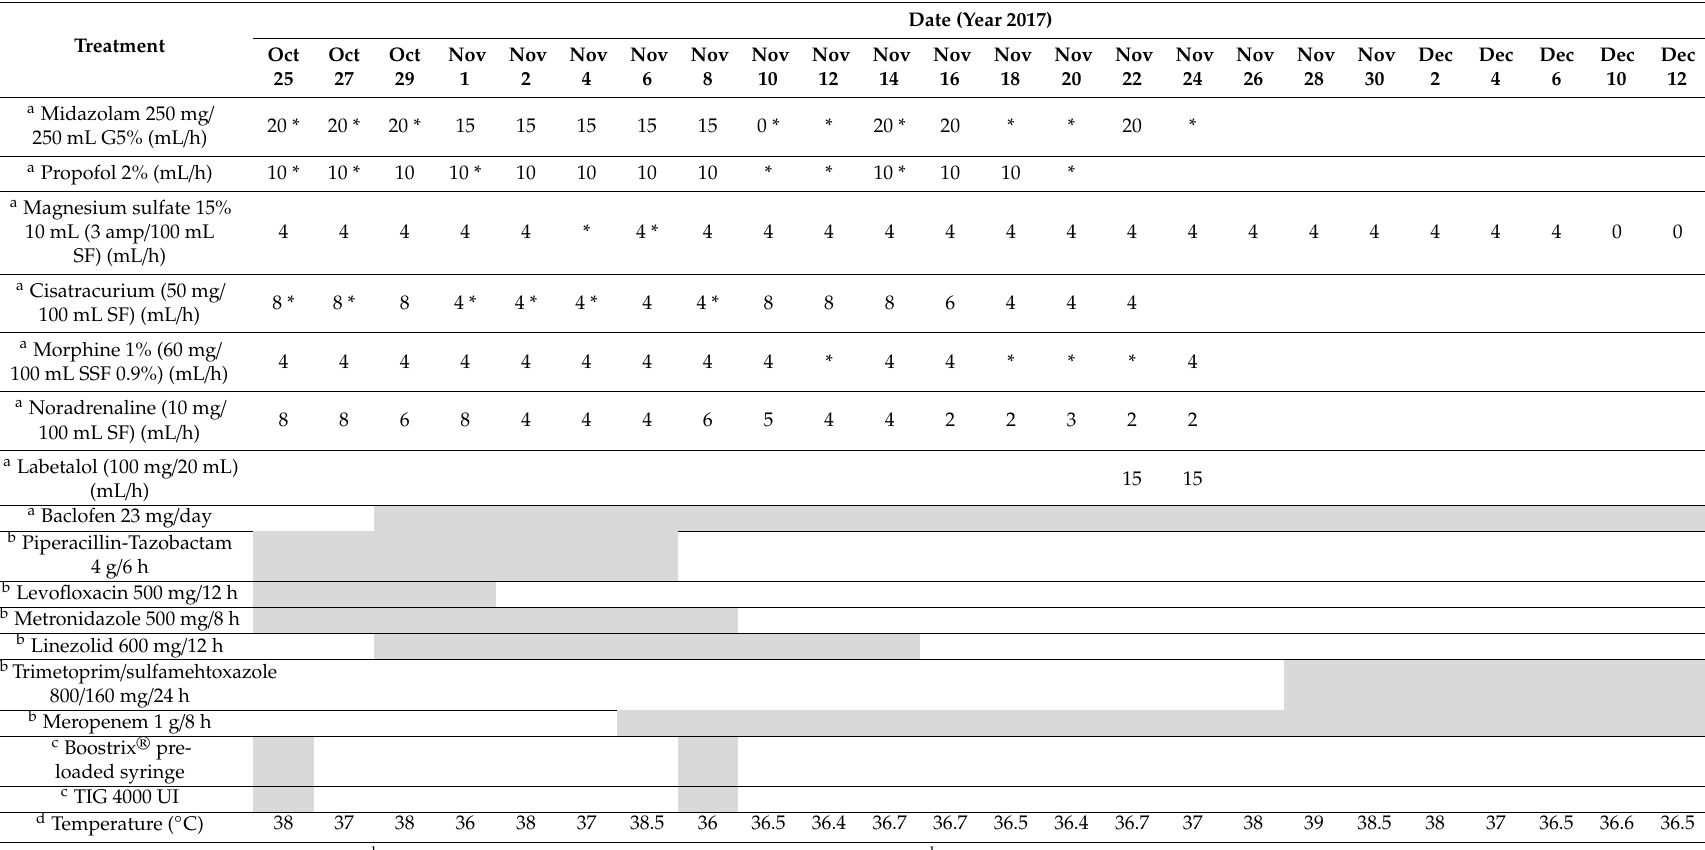
Table 2. Treatments administered during the hospital